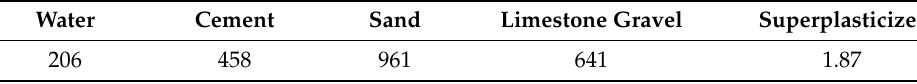
Table 1. Concrete mix ratio kg/m 3